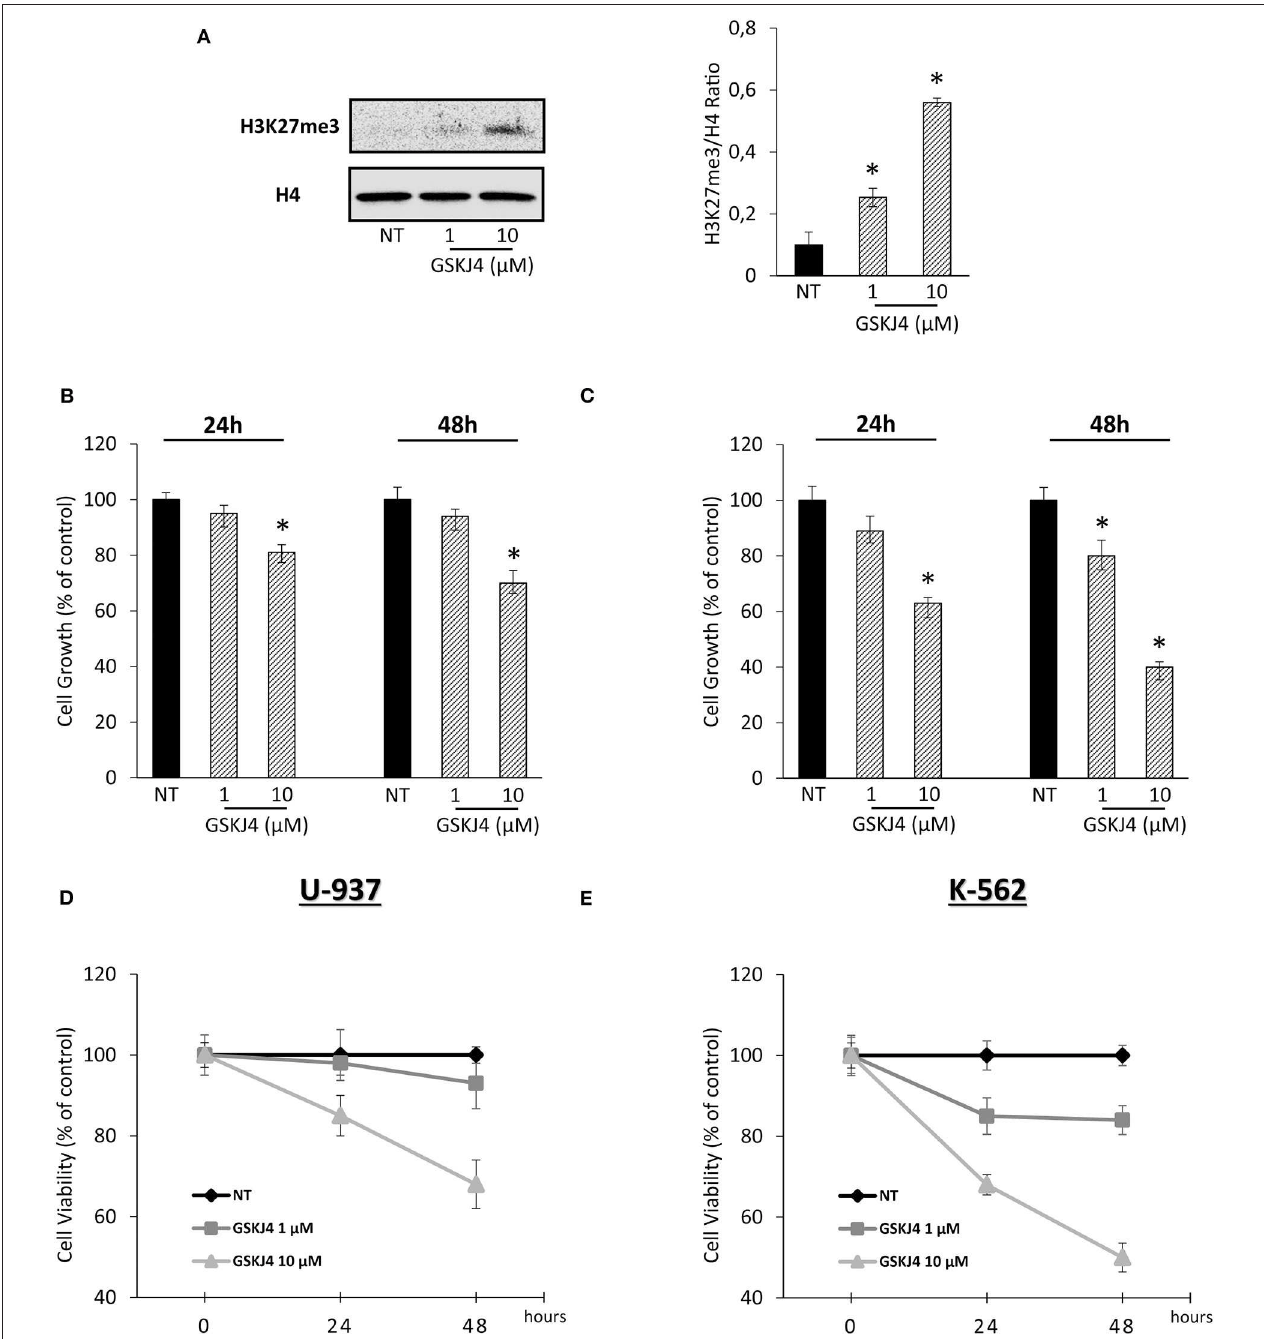
FIGURE 1 | Effects of GSKJ4 on H3K27me3 status in U-937 cells and cell viability/growth in U-937 and K-562. (A) H3K27 trimethylation levels were measured in U-937 cells treated or not (NT) with 1 and 10 µ M of GSKJ4 for 48h. U-937 (B) and K-562 (C) cells were cultured with or without (NT) 1 and 10 µ M of GSKJ4 for 24 and 48h. Later, 3-[4,5-dimethylthiazol-2-yl]-2,5-diphenyltetrazolium bromide (MTT) assays were performed in order to determine the relative cell viability amount. U-937 (D) and K-562 (E) cell number were recorded after treatment with 1 and 10 µ M of GSKJ4 at 24 and 48h. Cell viability and cell growth data were indicated in % of control. Mean and standard deviation (SD) values of at least three repeated experiments were reported. * P < 0.05 by unpaired t -test. we evaluated the p-Ser133-CREB and CREB protein